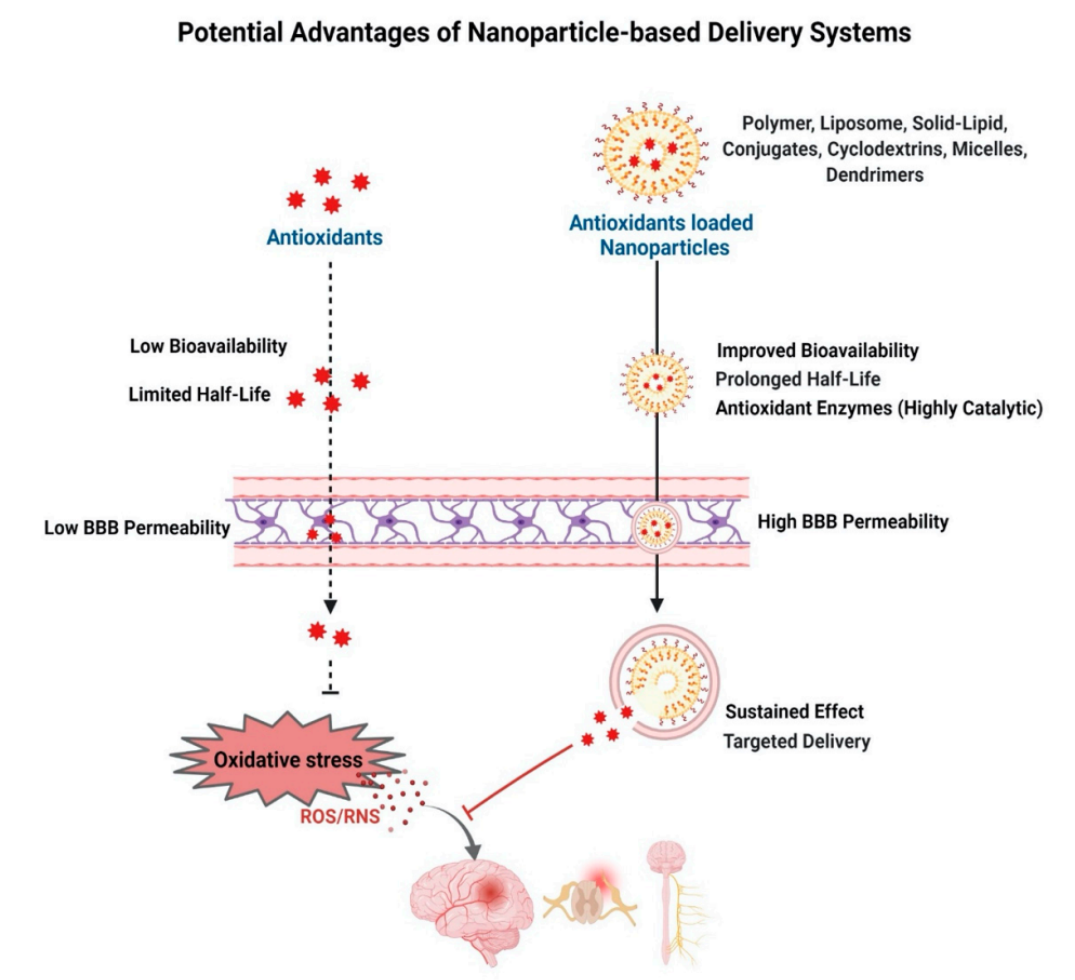
Figure 5. Antioxidant-based nanotherapy. Schematic depicting advantages of delivery of antioxidant- loaded nanoparticles to improve half-life of antioxidants and their ability to cross the BBB, improve bioavailability, and sustain the effect, thus effectively neutralizing oxidative stress in neurodegenera- tive